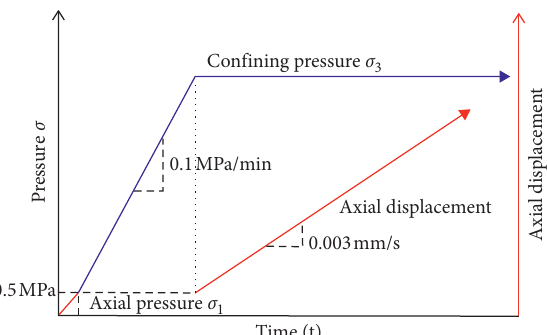
Figure 4: Stress loading path of the conventional triaxial test.